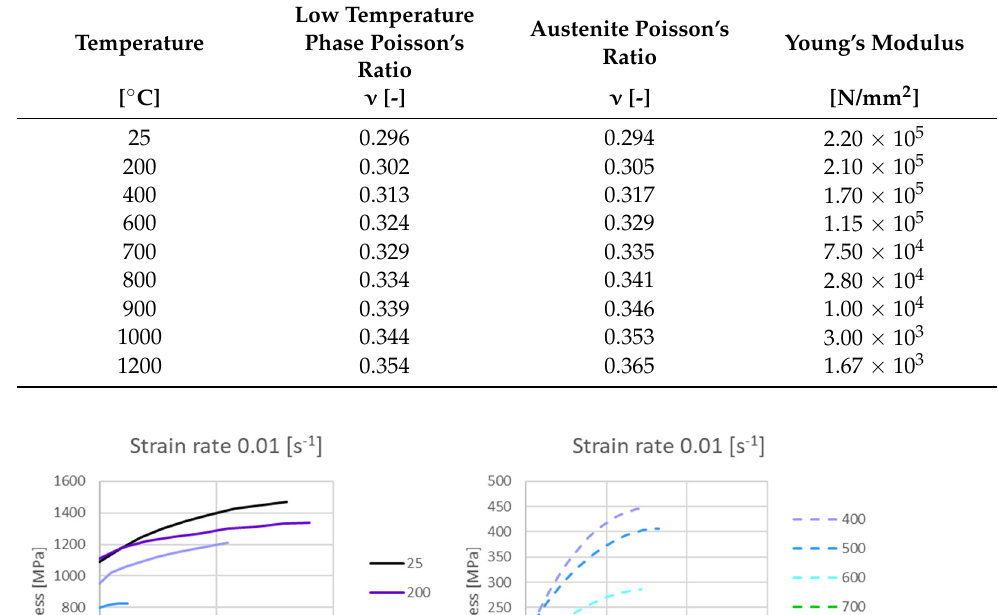
Table 6. Temperature dependent Poisson’s ratio of the low temperature phase and austenite as well as the phase independent Young’s modulus. Low Temperature Temperature Phase